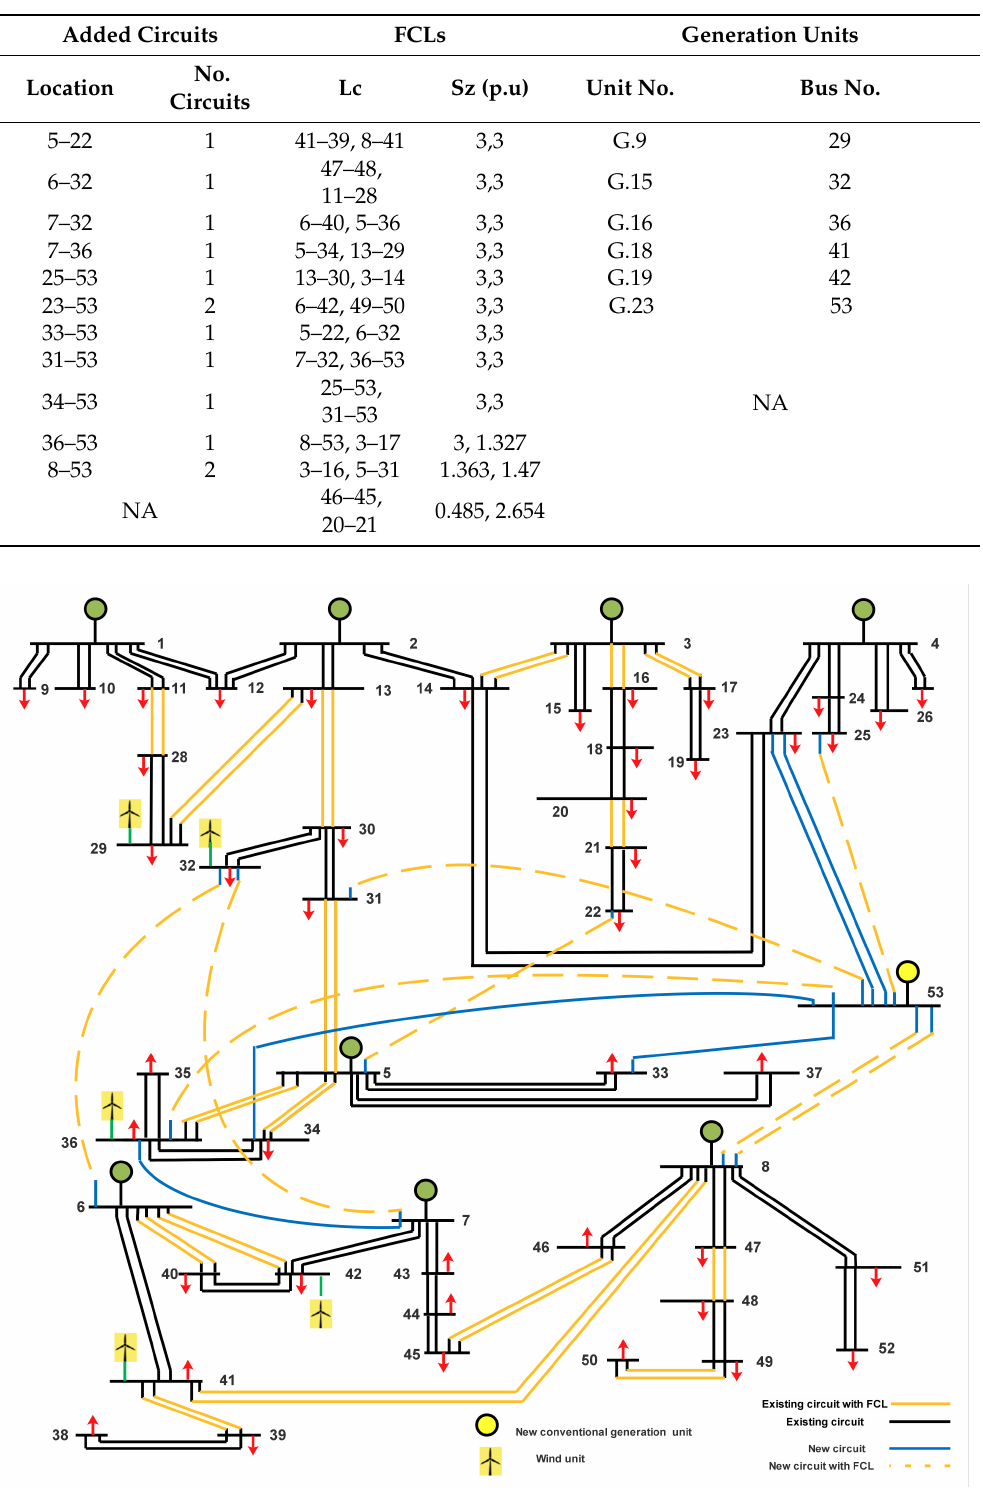
Table 6. Final configuration of WDN.